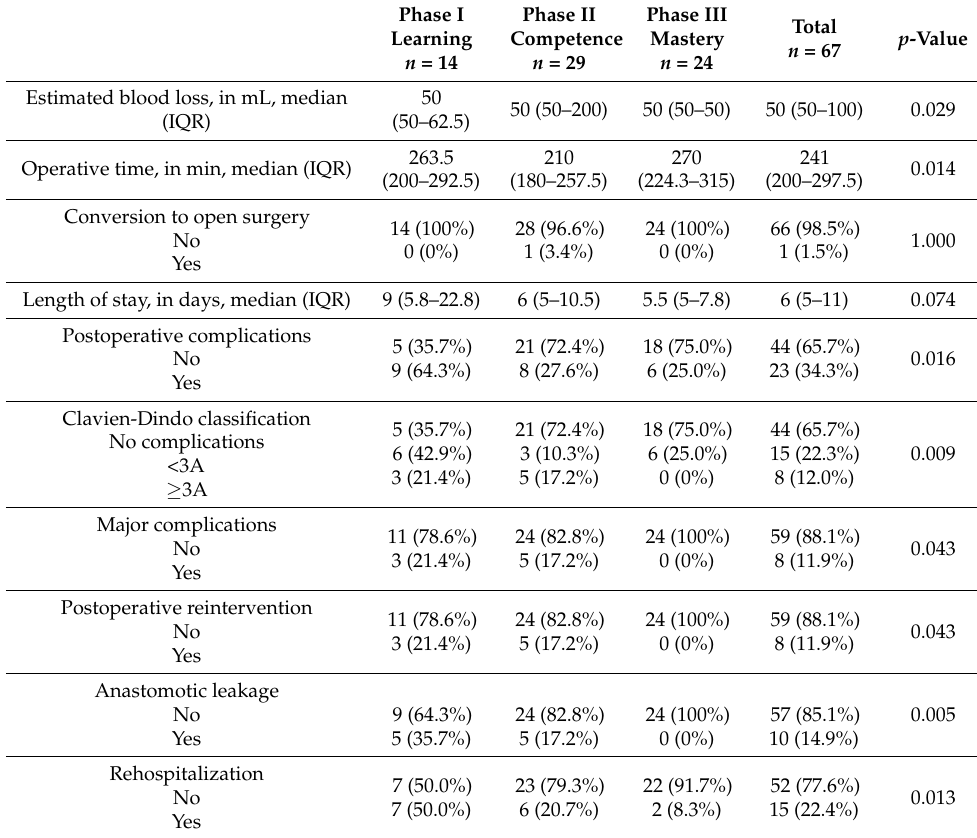
Table 3. Comparison of operative time in different phases of the learning curve for taTME for rectal